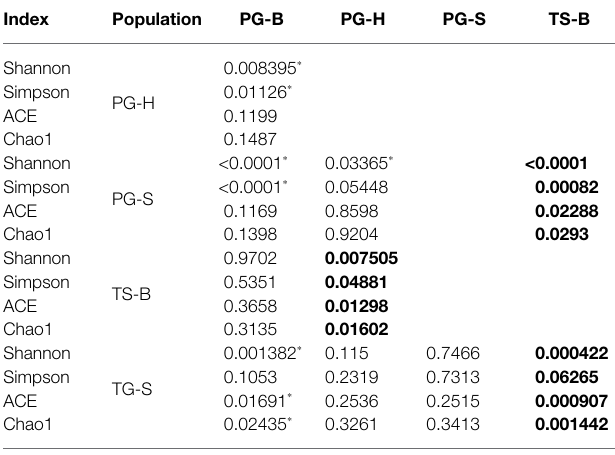
TABLE 4 | One-way ANOVA comparison (significant value) of diversity indices of fecal bacterial community in two wild Przewalski’s gazelle populations (PG-H and PG-S), one managed Przewalski’s gazelle population (PG-B), one Tibetan gazelle population (TG-S), and one Tibetan sheep population